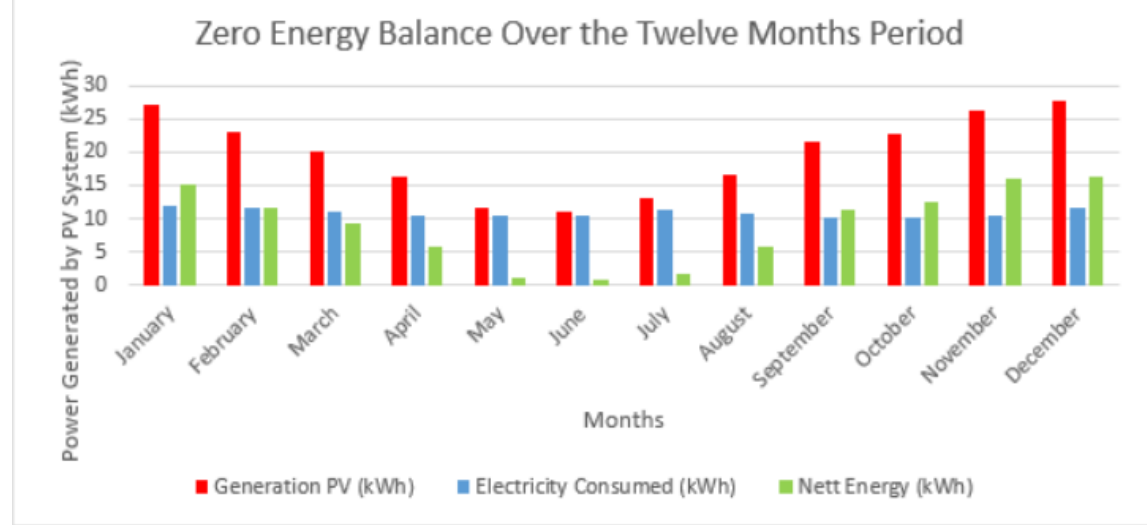
Figure 7: Zero energy balance of each month